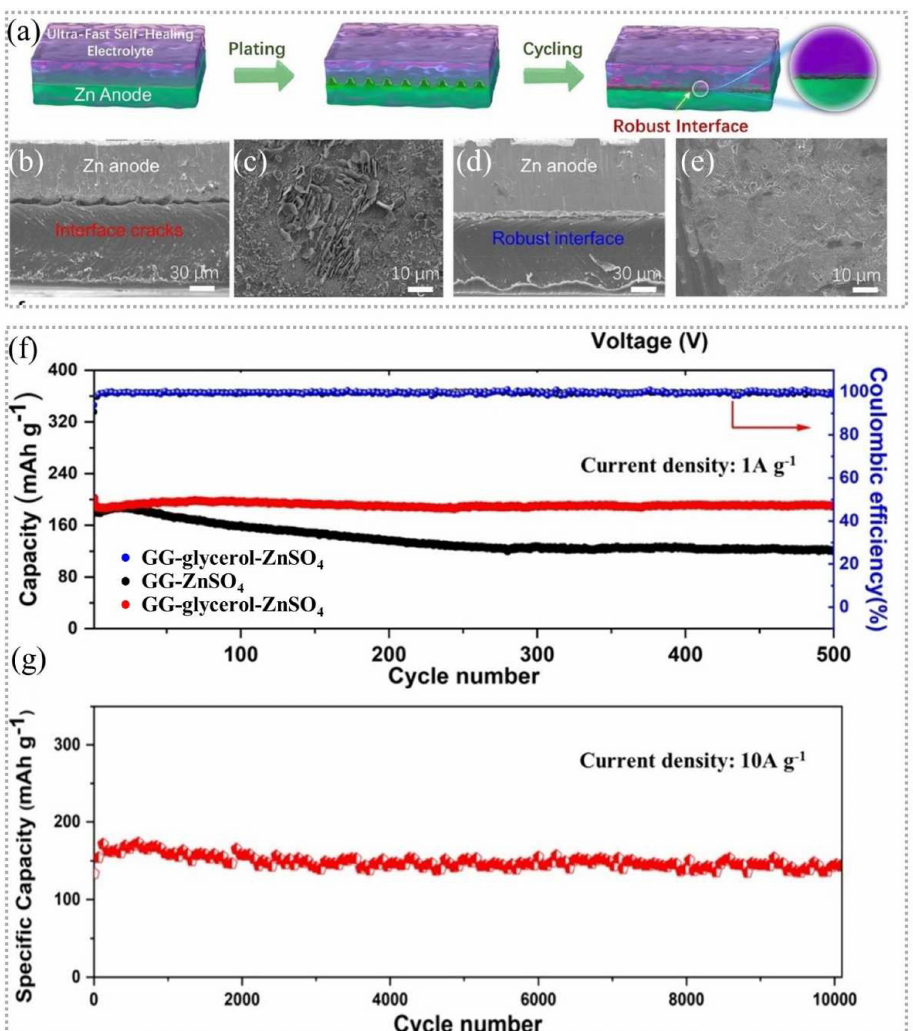
Figure 4. Characterizations of self-healing and self-adaptive interface. ( a ) Schematic diagram of the dendrite inhibition. ( b , c ) SEM images of Zn anodes after 250 cycles in the guar gum/ZnSO 4 electrolyte. ( d , e ) SEM images of Zn anodes after 250 cycles in guar gum/ZnSO 4 /glycerol electrolyte. ( f ) Long-term cycling performance at 1 A g − 1 . ( g ) Long-term cycling performance at 10 A g − 1 . Adapted with permission from Ref. [45]. Copyright 2022 ACS Energy